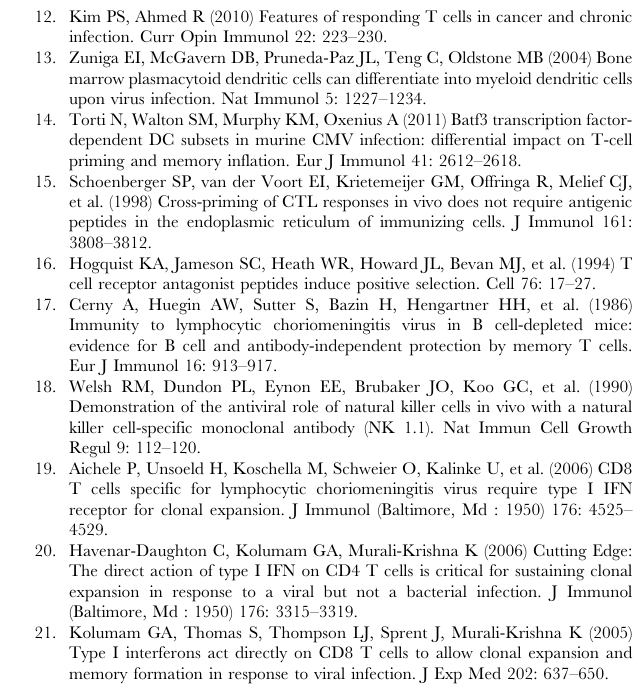
OT-I, ovalbumin-specific TCR transgenic line specific for the